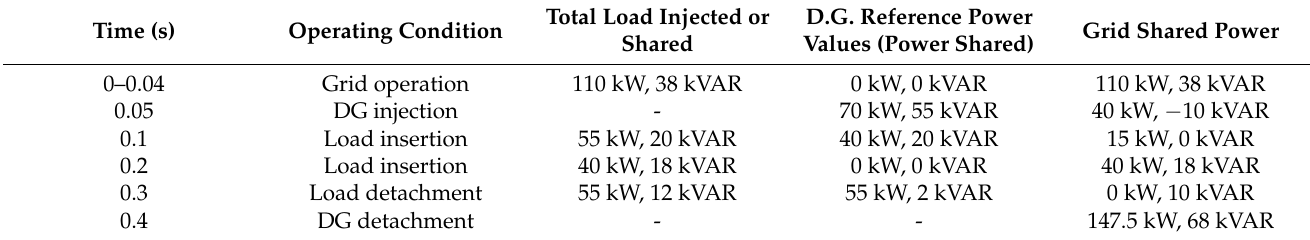
Table 2. Operating conditions and power-sharing between D.G. and utility